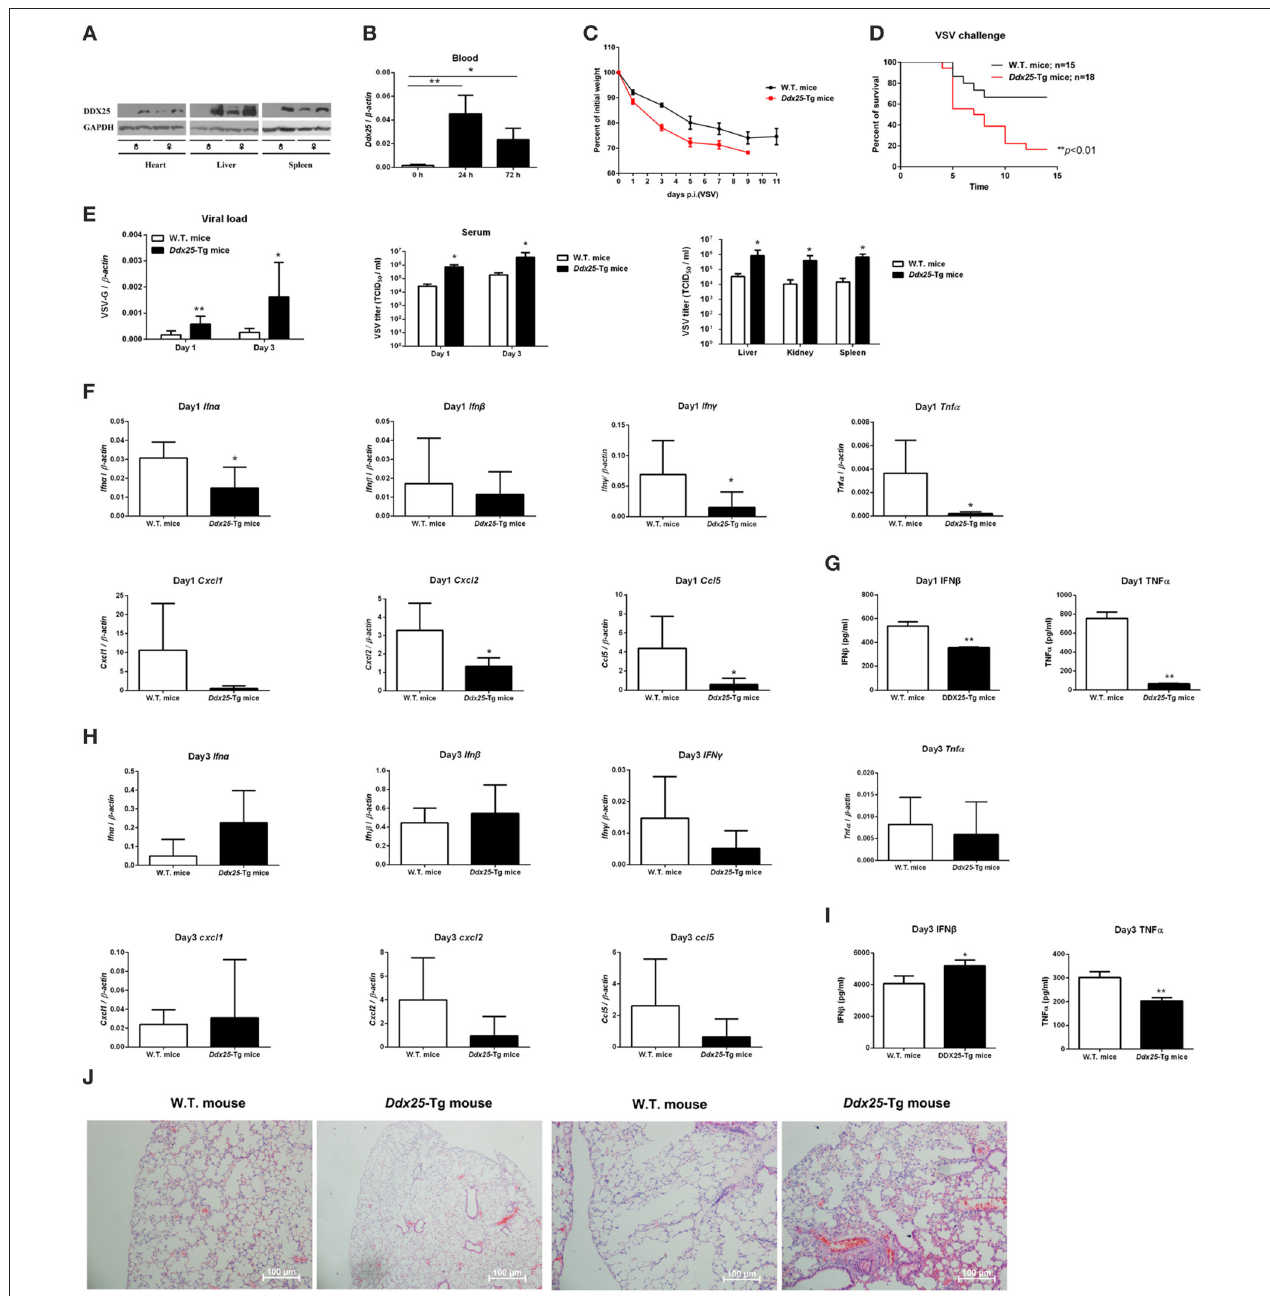
FIGURE 4 | Exacerbated VSV pathogenesis in Ddx25 transgenic mice. Seven to eight weeks old, sex-matched, C57BL/6 (W.T.), and Ddx25 -Tg mice were challenged with VSV (1 × 10 6 pfu /mouse). (A) Immunoblots of DDX25 in various tissues of W.T. and Ddx25 -Tg mice, suggesting the evaluated expression of DDX25 in Ddx25 -Tg mice. (B) qRT-PCR quantification of Ddx25 mRNA in whole blood cells of wild type (W.T.) mice during VSV infection for 0, 24, and 72 h. (C,D) Changes in body weight (C) and survival rate (D) of W.T., Ddx25 -Tg mice infected VSV, as monitored daily until days 11 and 14 post-infection, respectively. (E) VSV titers in the blood and tissue lysates of liver, kidney, and spleen from infected mice were measured via qRT-PCR and TCID 50 assay. ( F–I ) The expression levels of the selective cytokines/ chemokines (Ifn α , Ifn β , Ifn γ , Cxcl1 , Cxcl2 , Ccl5 , and Tnf α ) in total leukocytes of W.T. and Ddx25 -Tg mice ( N = 10 each) at day 1 (F,G) and day 3 (H,I) post-infection. Expression levels of mRNAs were determined by qRT-PCRs (F,H) . Protein levels of IFN β and TNF α in serums at day 1 (G) and day 3 (I) were determined by ELISA. Results were expressed as the mean + the SEM. * p < 0.05 and ** p < 0.01 ( t -test). Representative results from at least three independent experiments. (J) H&E staining of lung tissues of W.T. and Ddx25 -Tg mice at 2 days post mock infection (PBS) or VSV infection. Scale bars, 100 µ m.